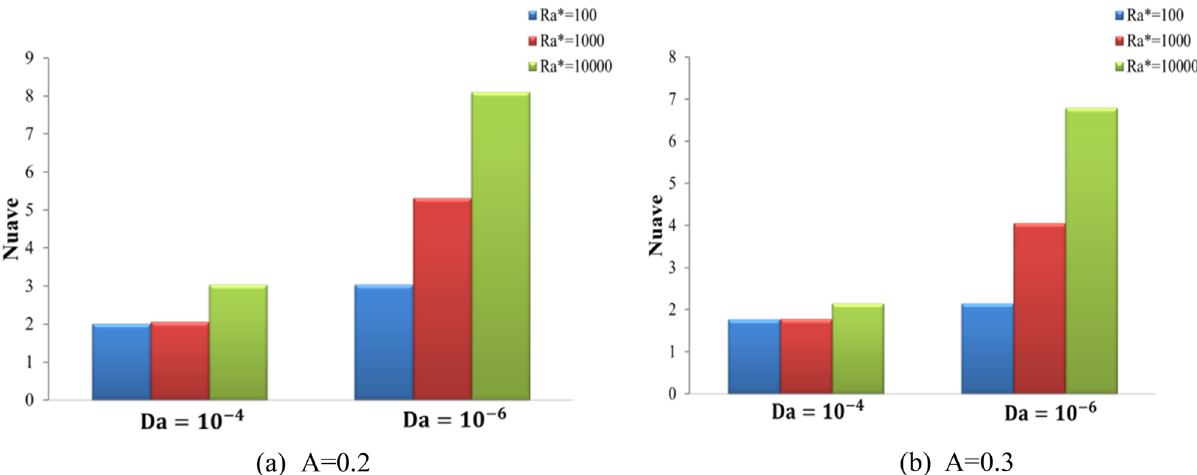
Figure 13. Difference of average Nusselt number (Nu ave ) with wavy wall for various Ra* and Da at N = 1, ϕ = 0.01, and ( a ) A = 0.2, ( b ) A =